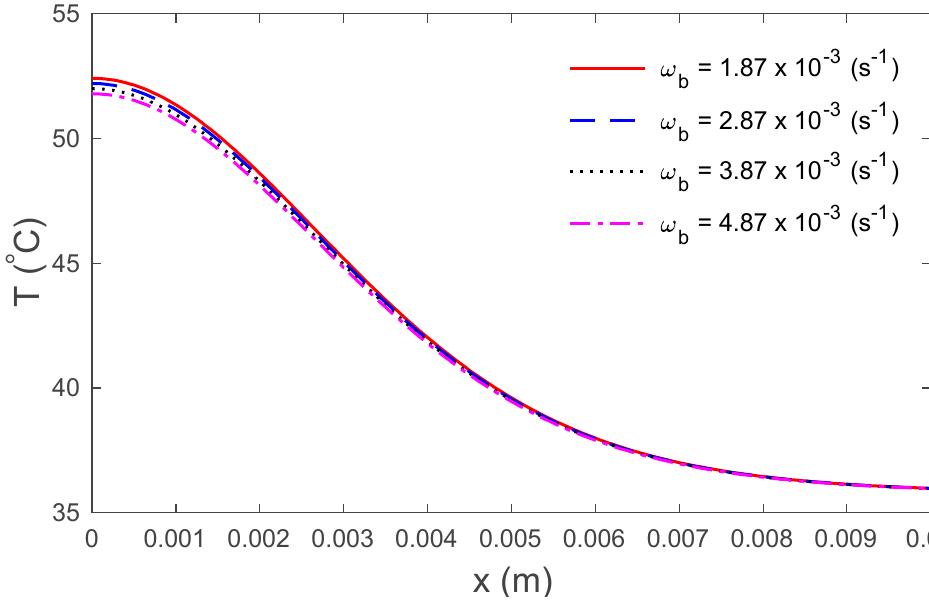
Figure 5. Variations in temperature versus the distance under the TPL model for several values of the rate of blood perfusion ω b .